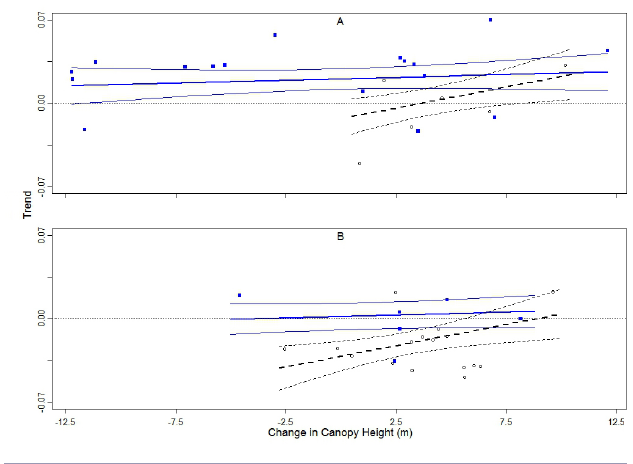
Fig. 9. Increasing trends in abundance of White-throated Sparrow in old (A) and young and mature (B) mixedwood forest stands in response to increasing stand height and disturbance between circa 1994 and 2014. Blue squares and solid lines depict trends (with 85% confidence intervals [dotted lines]) in disturbed stands. Open circles and black dashed lines depict trends in undisturbed stands (with 85% confidence intervals [dotted lines]). Predictions were generated using parameter estimates in Table 5 while holding change in conifer cover constant at the